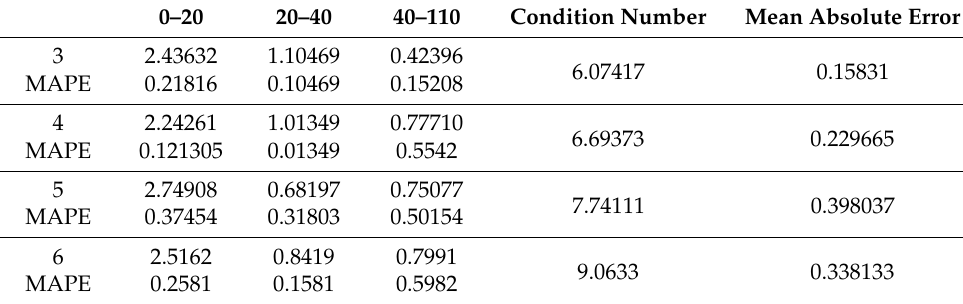
Figure 8. Least squares method to obtain the velocity compared with the real value. Table 2. Flow velocity inversion results.